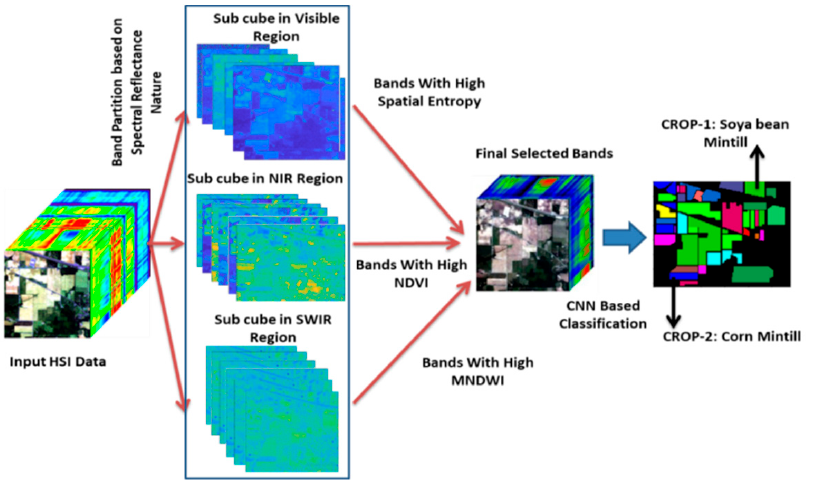
Figure 2. Architecture of the proposed partition-based band selection and CNN-based classification for crop classification .